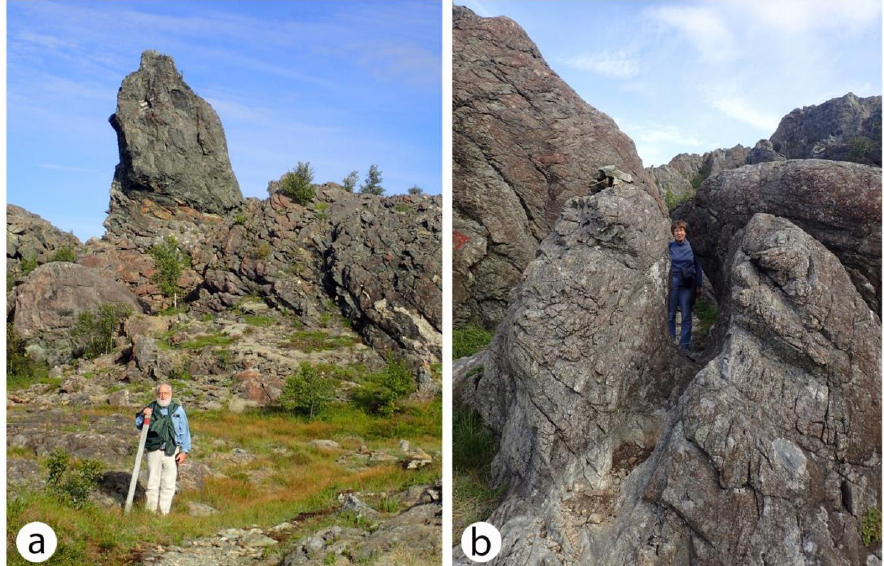
Figure 2. The raised shoreline now about 100 m above sea level at the base of Lekamøyhammaren Mountain (see Figure 1b): ( a ) Gabbro sea stack attributed by legend to the stony embodiment of the Leka troll maiden (author for scale) and ( b ) wave-polished surge channel eroded in gabbro close by the sea stack (figure for scale).